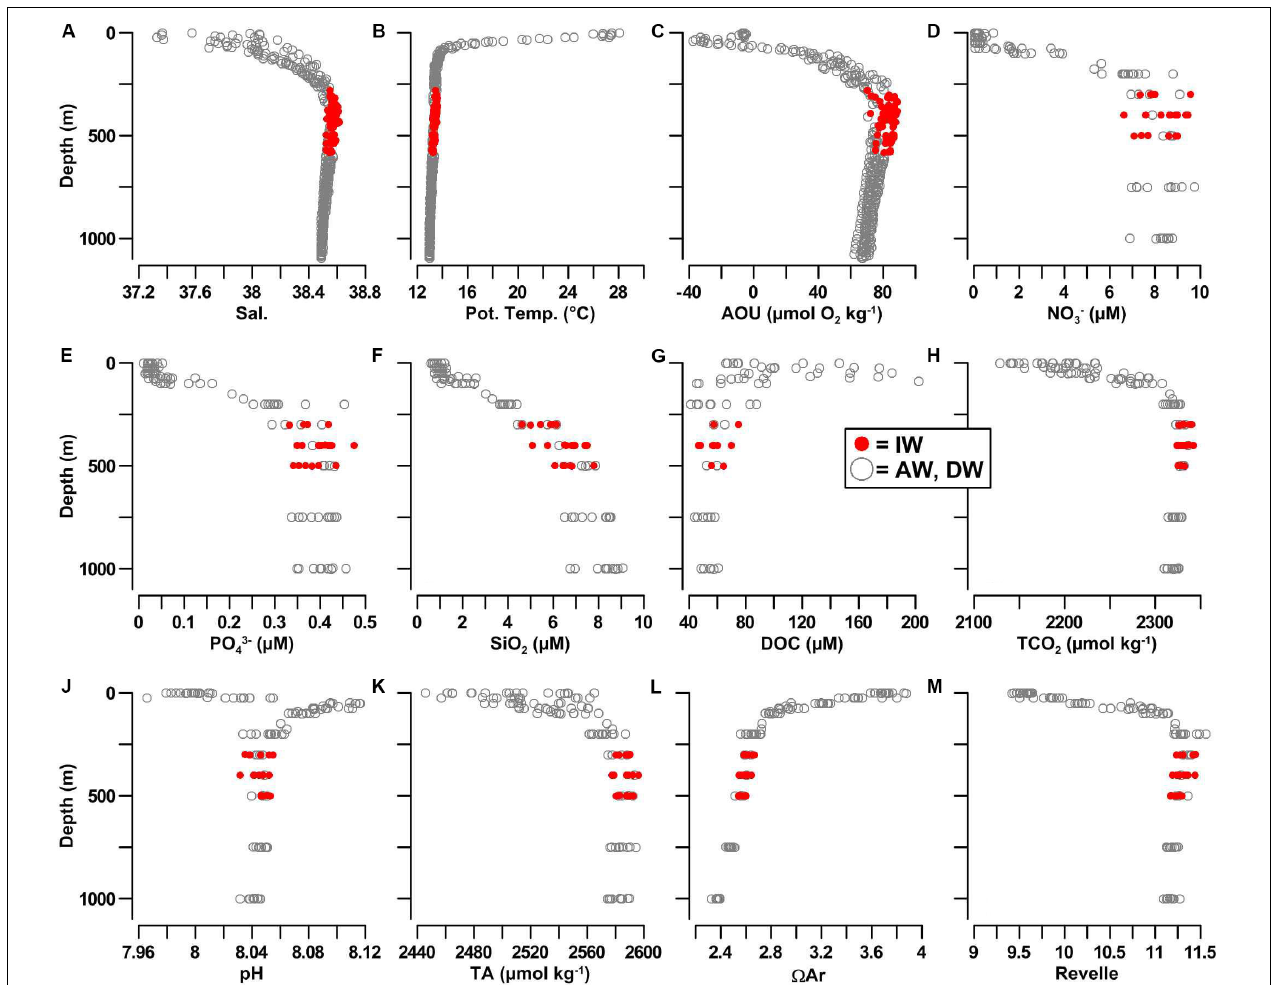
FIGURE 6 | Vertical profiles of in situ biogeochemical properties of IW (black dots) in IVb, VIb and VII, compared to the surrounding waters, AW and DW (gray circles). Vertical profiles of (A) salinity, (B) potential temperature, (C) AOU, (D) nitrate, (E) phosphate, (F) silicate, (G) DOC, (H) TCO 2 , (J) pH, (K) TA, (L) (cid:127) Ar, and (M) Revelle.